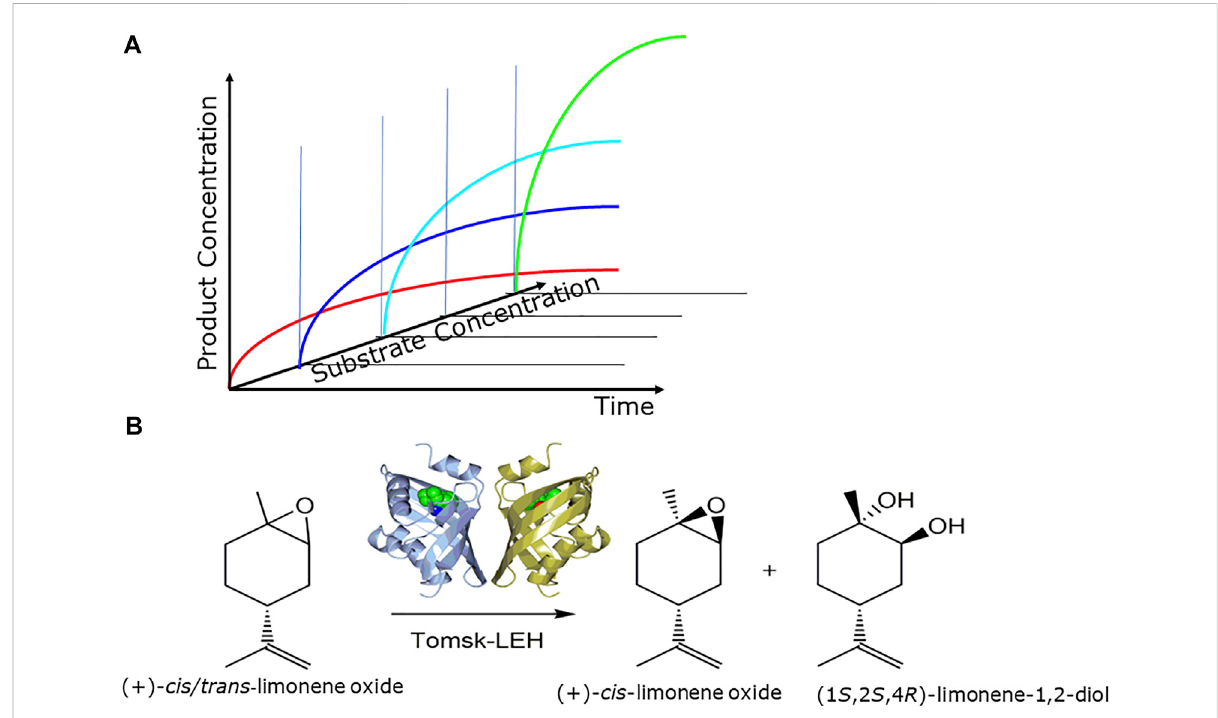
FIGURE 6 (A) Optimizing process metrics by increasing substrate concentration while maintaining complete conversion, (B) intensi fi cation of epoxide- hydrolase catalyzed resolutions of (+)-and ( − )-cis/trans-limonene oxides, as illustrated for the Tomsk limonene epoxide hydrolase (LEH) for the production of (+)-cis-limonene oxide and the (1S,2S,4R)- limonene-1,2-diol (Ferrandi et al.,